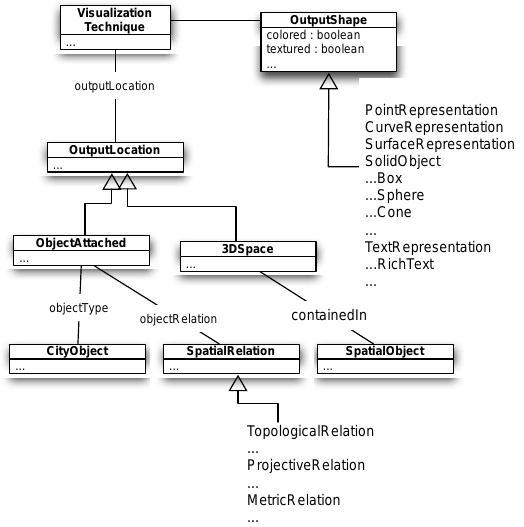
Figure 3. OutputRendering representation